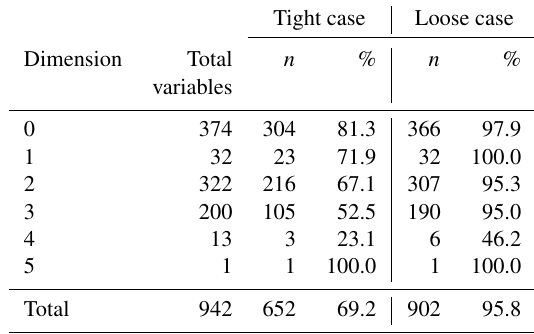
Table 3. The table presents the total number of variables that were included in the analysis split by the dimension of the arrays (0 for scalars). Also shown are the number of variables that can safely use single precision for the two cases discussed in Sect. 3.1 (tight and loose) and the percentage of the total variables that this represents. Using tight constraints, 69.2% of the variables can use single preci- sion, although only 52.5% of the 3-D variables are responsible for the most memory usage. Using loose conditions, 95.8% of the vari- ables can use single precision, including 95% of the 3-D